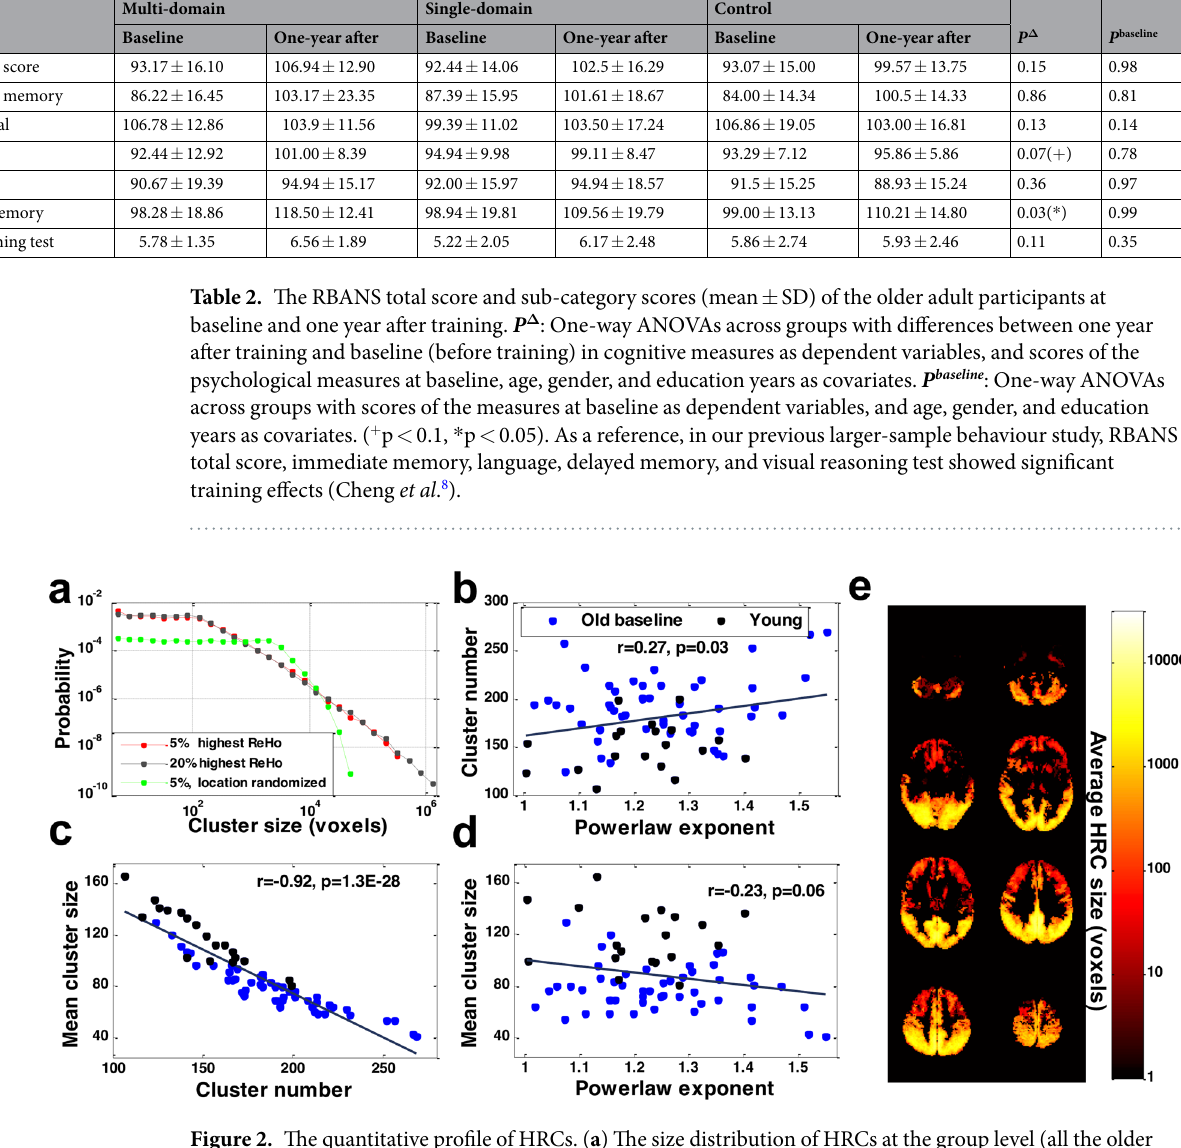
HRC overview: number, average size, distribution, and age difference.